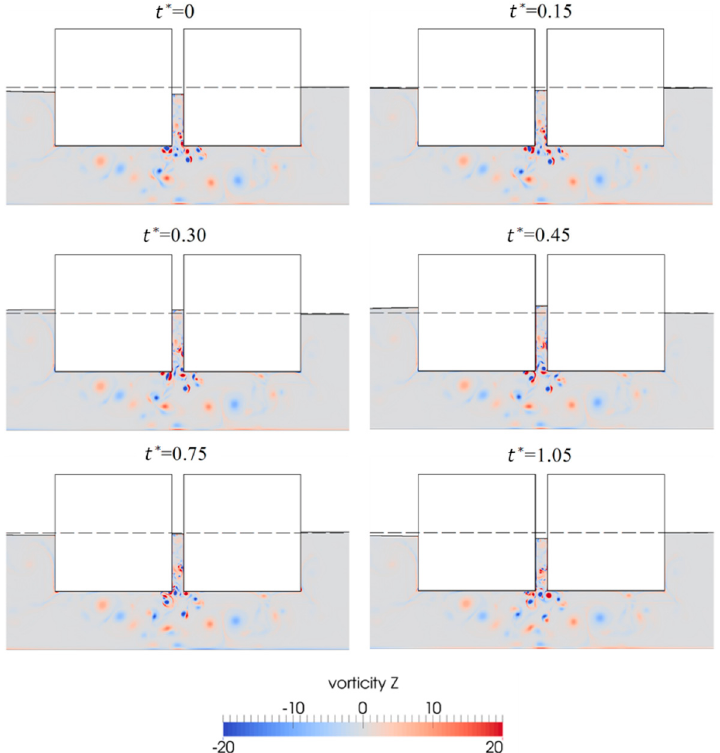
Figure 8. The variations of the vorticity contour in the water phase for Case C2 (incident wave frequency smaller than the resonance frequency) at different time instants .